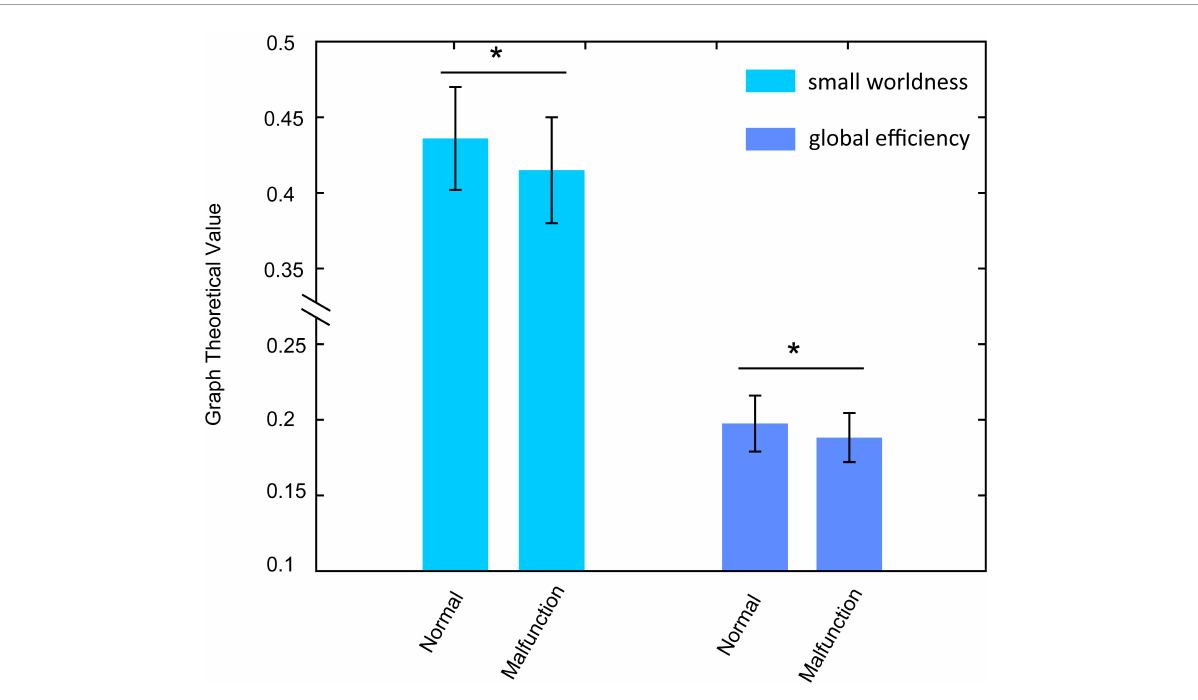
FIGURE6 The small worldness and local efficiency alterations between normal condition and malfunction condition in the CA condition. Both two indexes show significantly lower values in malfunction conditions. * p <